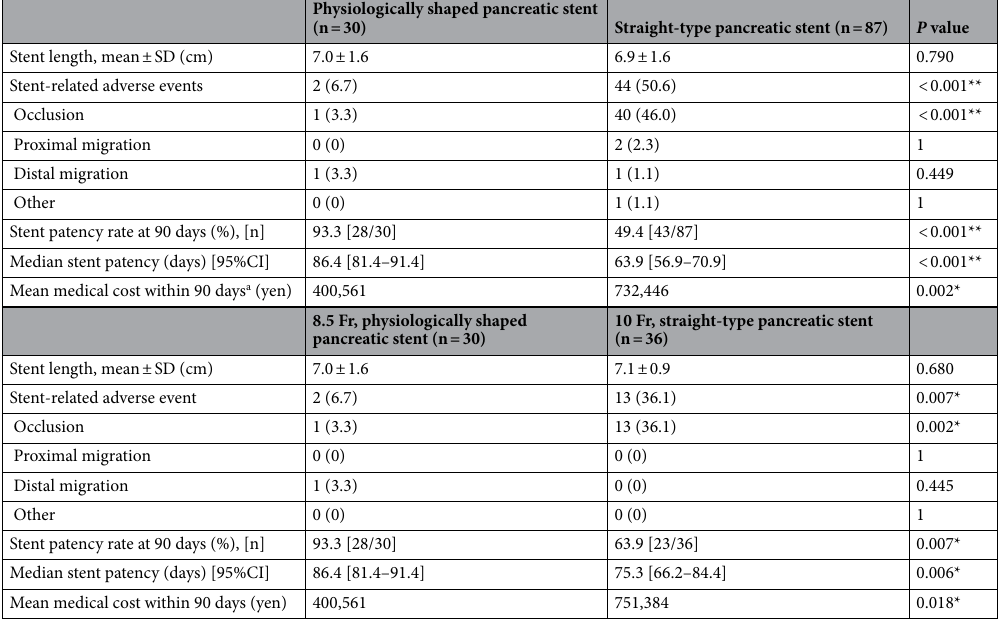
Table 2. Comparison of physiologically shaped and straight-type pancreatic stents. CI , confidence interval; Fr , French; SD , standard deviation. * P < 0.01; ** P < 0.001. a Values are presented in Japanese yen. Each cost equals to approximately 3725 and 6811 US dollars,